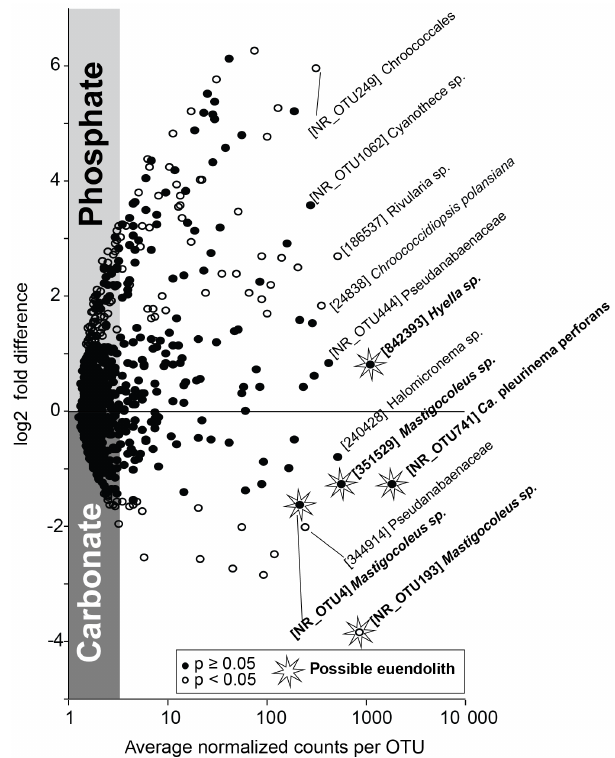
Figure 5. Differential abundance of cyanobacterial OTUs in Ca car- bonate (calcite–aragonite) n = 14 vs. Ca phosphate (apatite) n = 3 samples This plot was constructed using the DESeq2 method. It dis- plays the average normalized counts per OTU as a measure of abun- dance against the log2 fold difference. The OTUs that were signif- icantly differentially abundant in the two conditions ( p <0.05) are represented as open circles; the other ones are displayed as close symbols. Positive values indicate enrichment towards Ca phosphate and negative values indicate enrichment towards Ca Carbonate. The OTU ID and taxonomical assignment of the most abundant OTUs is displayed on the right. The stars tag the possible euendolithic OTUs as determined by phylogenetic proximity to known micro- borers (Fig.